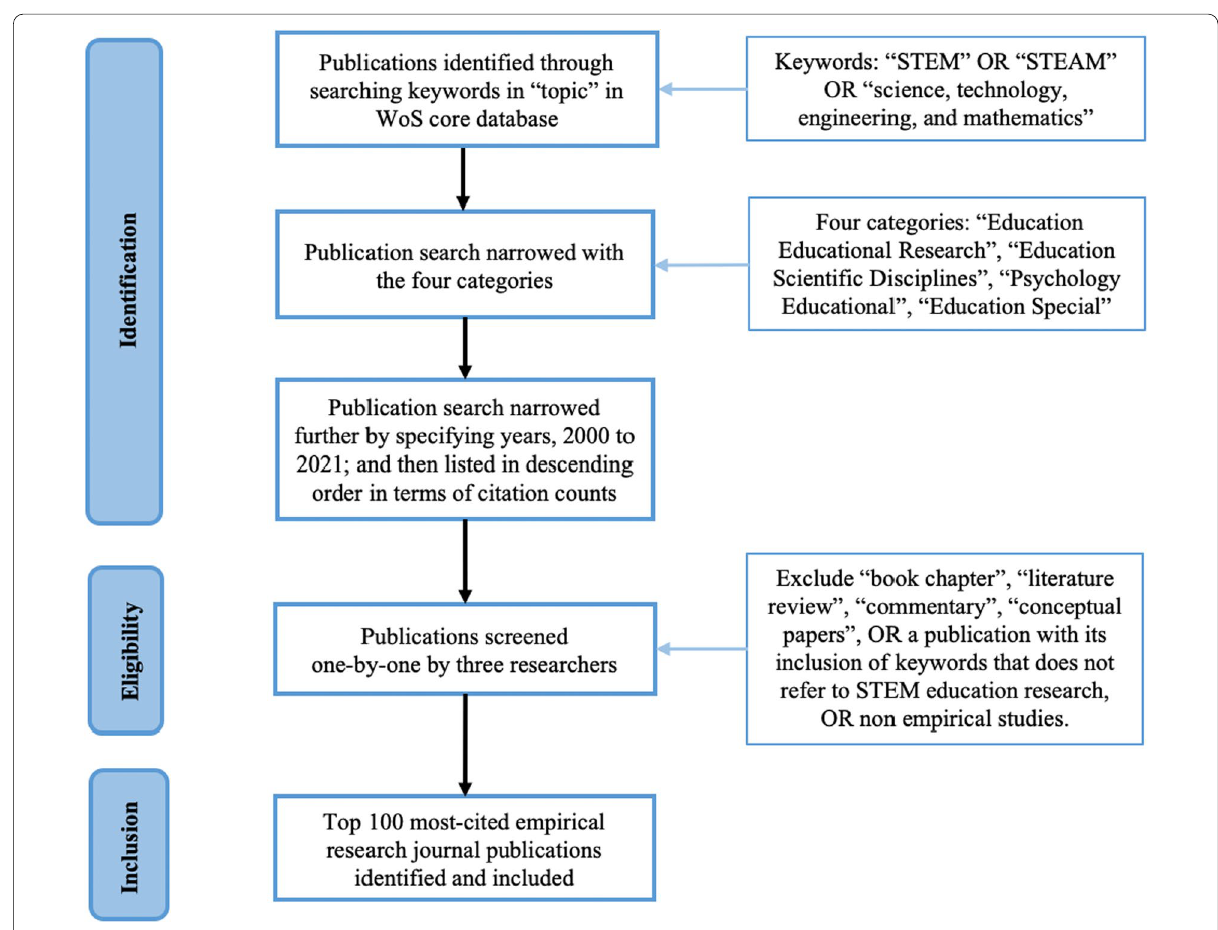
Fig. 1 Flowchart of publication search, identification, and selection process